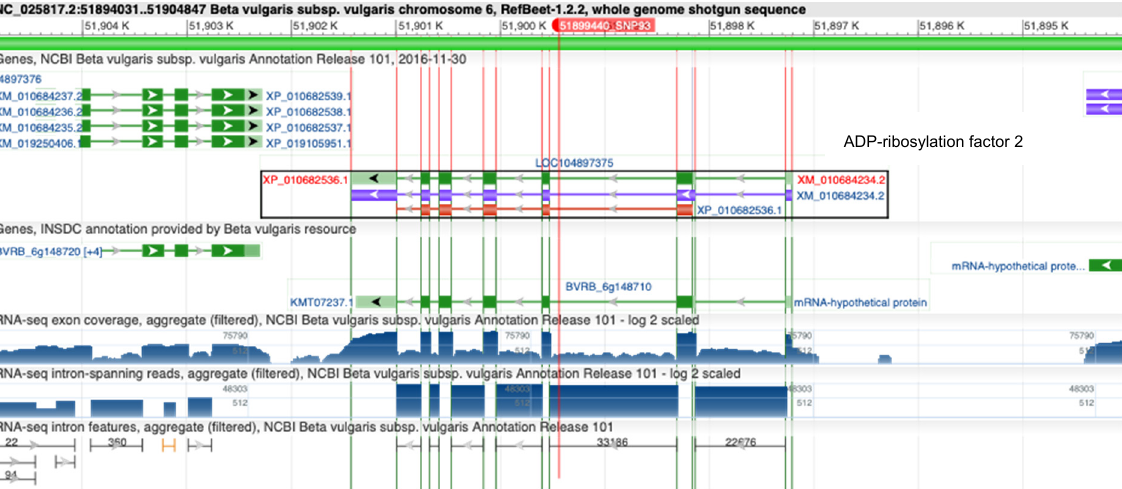
Figure 7. Genomic context of RsBv1 in the RefBeet1.2.2 sugar beet reference genome [29]. It is located within the intron of LOC104897375 coding for ADP-ribosylation factor 2.